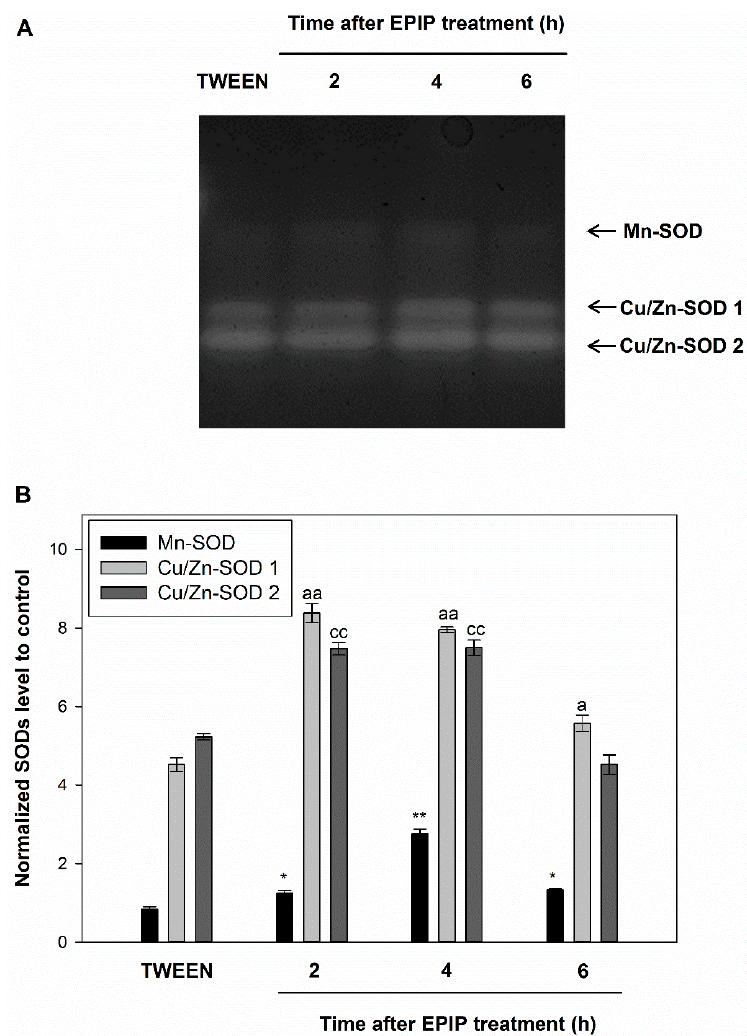
Figure 4. Exogenous EPIP affects the enzymatic activity of superoxide dismutase (SOD) in the floral abscission zone (AZ) of yellow lupine. SOD isoenzyme profile was obtained for fragments of AZ excised at 2 h, 4 h, and 6 h after EPIP (100 µ M) solution in 0.05% Tween 20 treatment. EPIP was applied directly to inactive AZ. The inactive AZ was dissected at the same time variants from the flower bases after the application of the 0.05% Tween 20 solution. Mn-SOD and two isoforms of Cu/Zn-SOD were detected using an in-gel assay. Representative micrograph of NBT-stained gel is presented ( A ). The chart ( B ) displays the average densitometry data corresponding to the bands detected on three separate gels. Each band was quantified and expressed as value compared to inactive AZ. The values for each isoform were normalized to the inactive AZ after Tween 20 application. Data are presented as averages SE. For Mn-SOD, significant differences for EPIP treated ± plants in comparison to control are indicated as * p < 0.05, ** p < 0.01; for Cu/Zn-SOD1, significant differences for EPIP treated plants in comparison to control are indicated as a p < 0.05, aa p < 0.01; for Cu/Zn-SOD2, significant differences for EPIP treated plants in comparison to control are indicated as cc p <